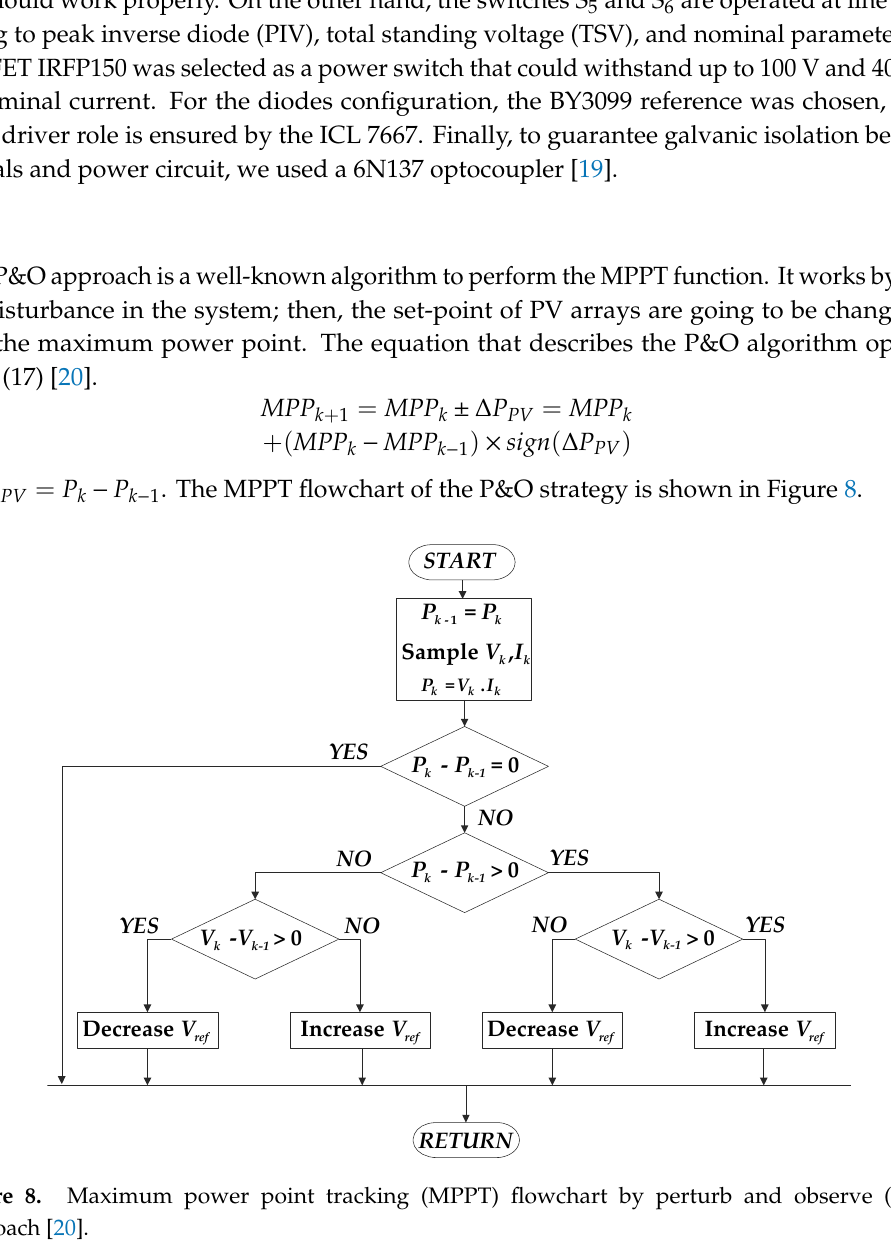
Figure 8. Maximum power point tracking (MPPT) flowchart by perturb and observe (P&O) approach